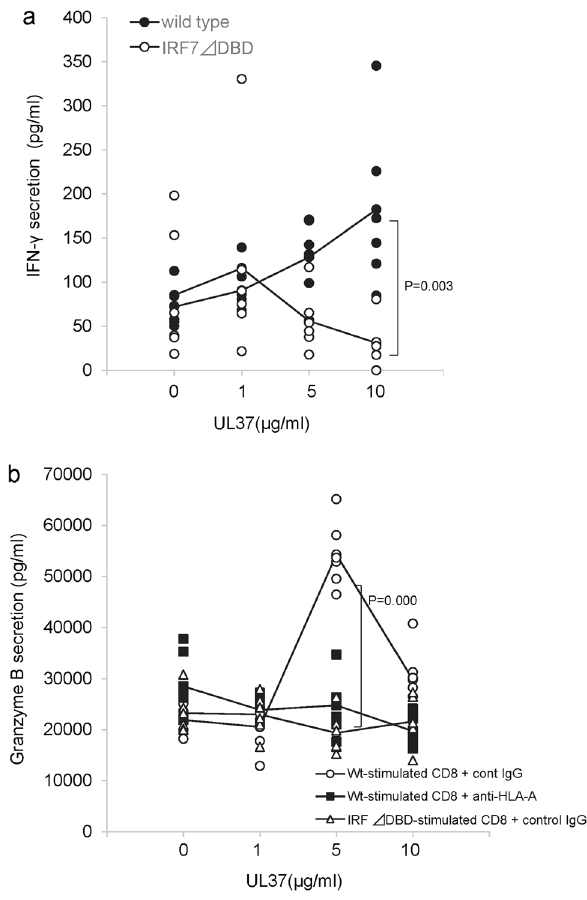
Figure 4. Role of IRF7 for CD8 cytotoxic T lymphocyte priming by infected HCEn cells. ( a ) Peripheral blood-derived allo-CD8 + T lymphocytes from MHC class I matched donor (A*2402) were stimulated